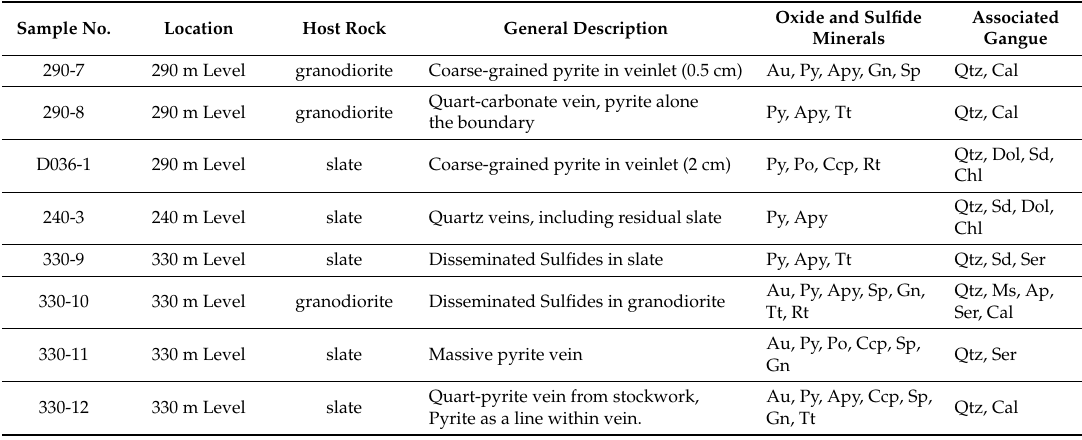
Table 1. Location, host rock, general description and ore minerals of the analyzed samples from the Zhengchong deposit (wt